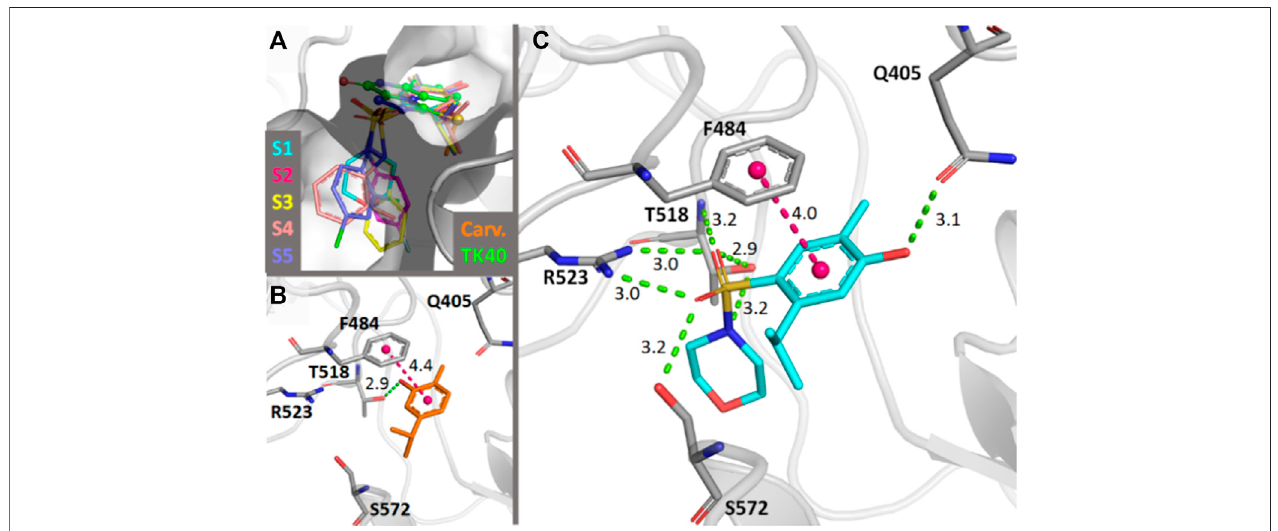
FIGURE 7 | (A) Docking-predicted binding modes in the rattus norvegicus NMDA-glycine binding site (PDB ID 4KFQ). The carbon atoms of each molecule are represented in a different color. The carbon atoms of the crystallographic antagonist TK40 are shown in green. (B) Main interactions established by carvacrol in the predicted binding mode. (C) Main interactions found by S1 in the predicted binding mode. Hydrogen bonds are represented in green and π -interactions in magenta. Distances are in Å.